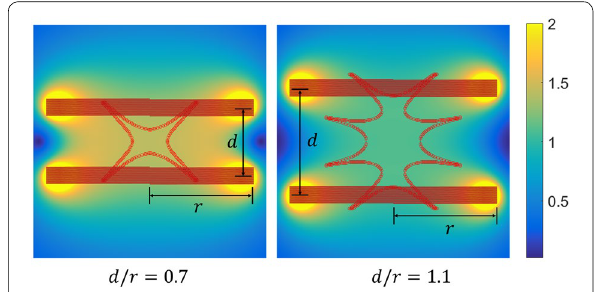
Figure 5 Magnetic field of the coil pair and its maximum usable region for different d /